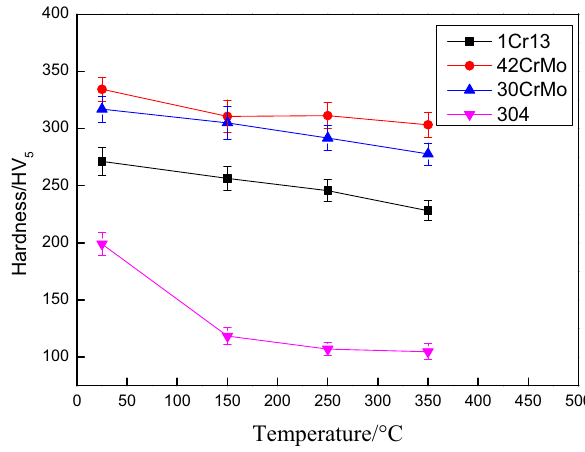
Figure 10: Microhardness of 30CrMo, 42CrMo, 1Cr13, and stainless steel 304 at 25, 150, 250, and 350°C.